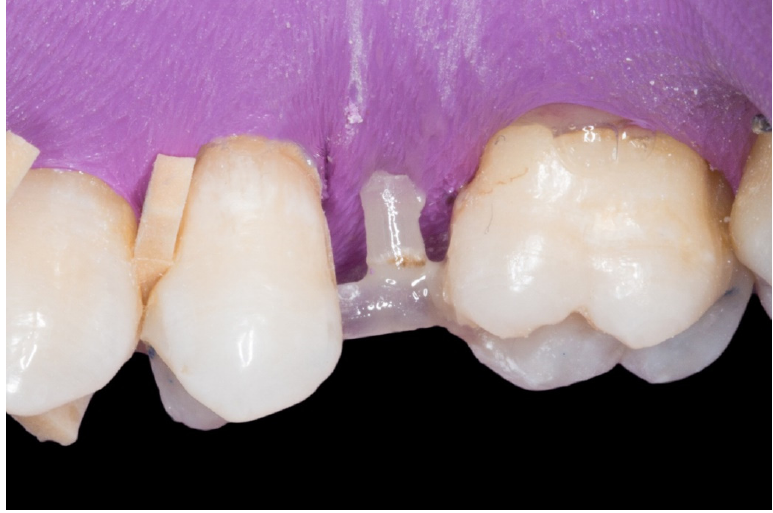
Figure 5. “T” shape of the fiber-reinforced composite bridge.